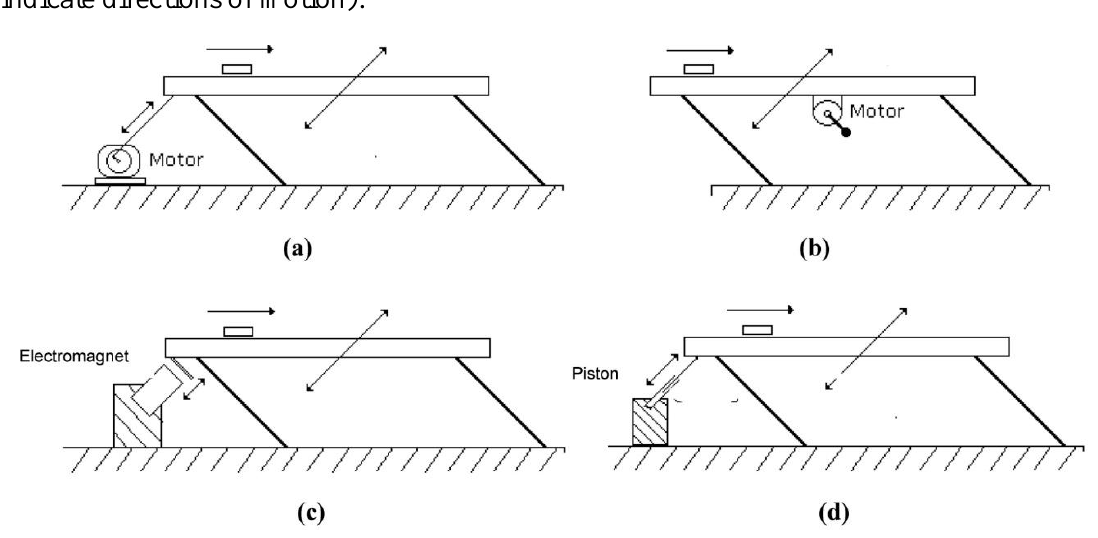
Figure 2. Traditional types of excitation mechanisms of vibratory feeders. ( a ) crank mechanism; ( b ) unbalanced mass; ( c ) electromagnetic; ( d ) pneumatic/hydraulic (the arrows indicate directions of